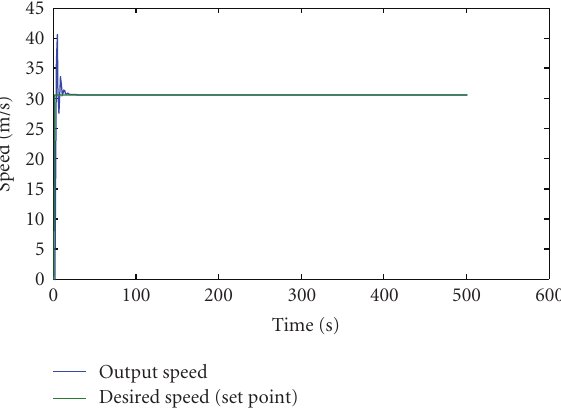
Figure 8: Response of speed for linear